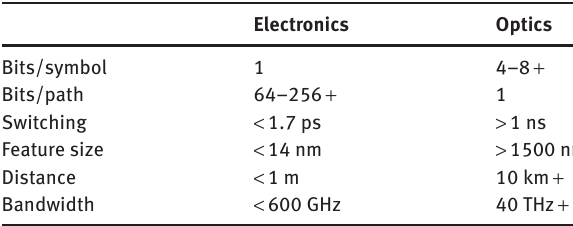
Table 1: Domain impact on computation and communication.